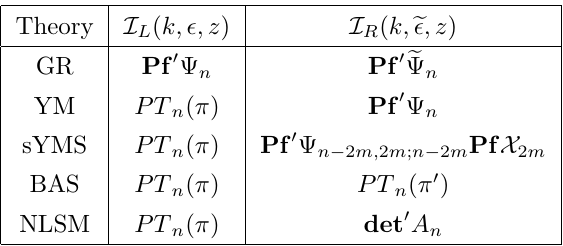
Table 1 . Integrands for various